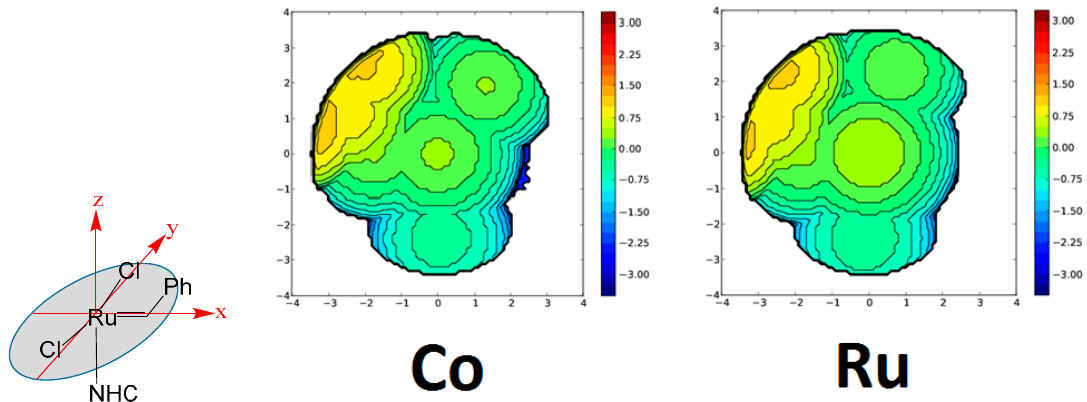
Figure 3. Topographic steric maps for the Co- and Ru-based catalyst I . The metal is at the origin, and the P atom is on the z -axis (Bz = benzylidene). The isocontour curves of the steric maps are given in Å. The radius of the sphere around the metal center was set to 3.5 Å; the Bondi radii were scaled by 1.17 for all the atoms, and a mesh of 0.1 Å was used to scan the sphere for buried voxels.